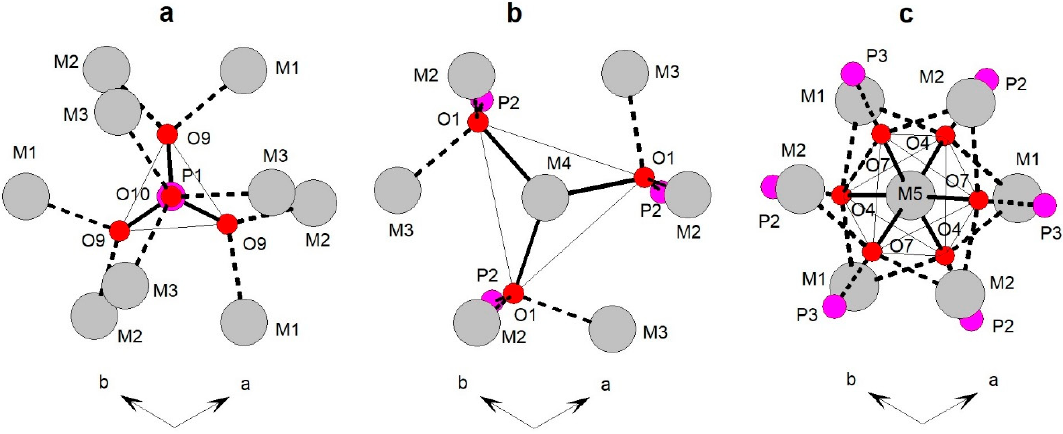
Figure 6. ‘A’ array in Me β -TCP structure: details of sharing vertices of P1O 4 ) ( a ); M4O 3 ( b ); and M5O 6 ( c ) with polyhedra from ‘B’ array.